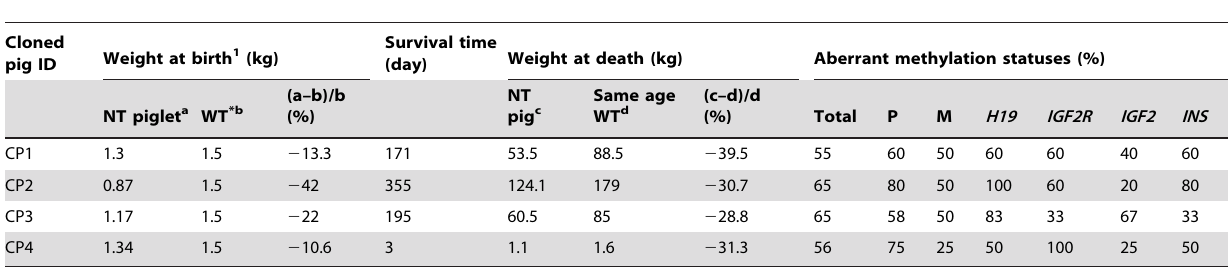
Table 1. Body weight, survival time, and aberrant methylation status of imprinted genes in wild-type and of cloned pigs.